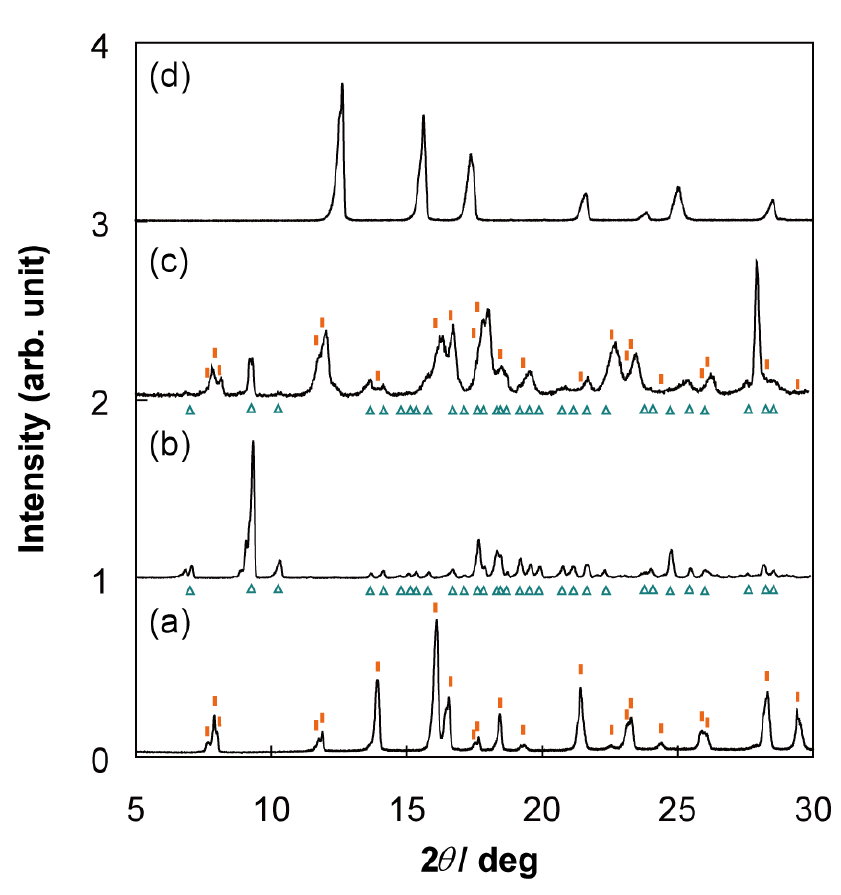
-(mesitylene) ] IC prepared by 0.5 0.25